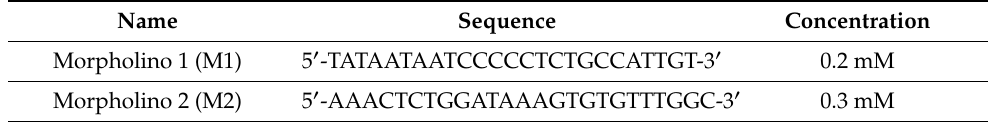
Table 2. The sequences of